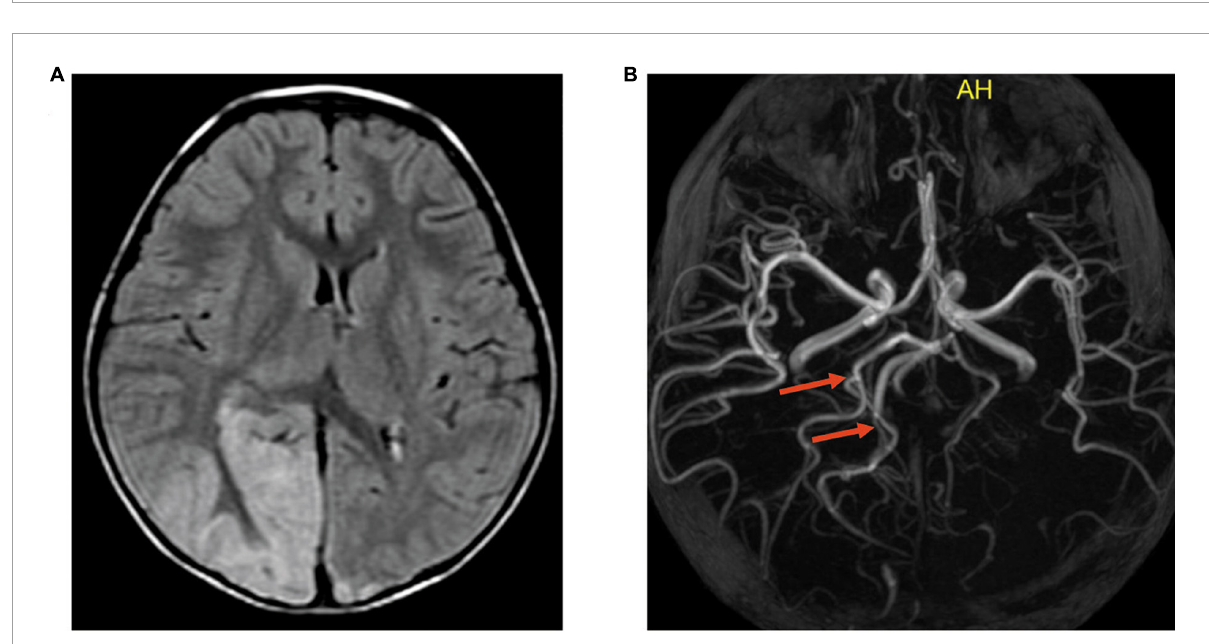
FIGURE6 Slightly dilated cerebral artery and the branches relevant to the lesion on MRA. Case 9, A 5-year-old boy with MELAS. (A) Transverse FLAIR images showed cortical swelling in the right occipital lobe. (B) MRA showed that the right posterior cerebral artery and the branches relevant to the lesion (indicated by the red arrows) were slightly dilated compared with the